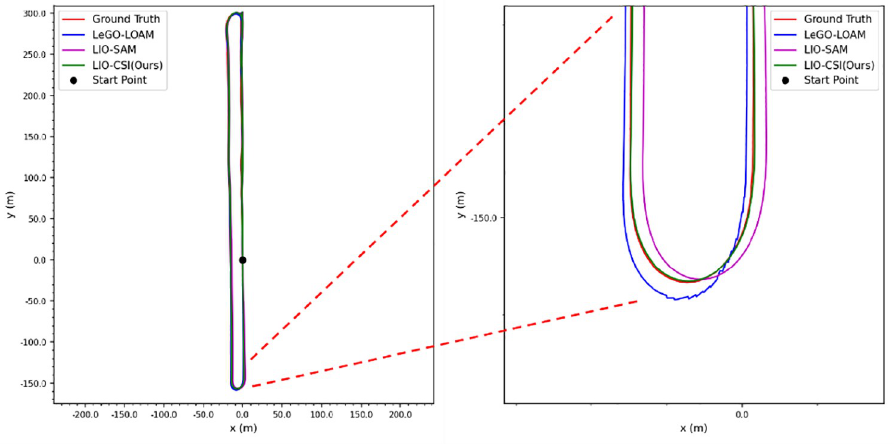
Fig 9. Trajectory comparison on sequence 06 of the KITTI